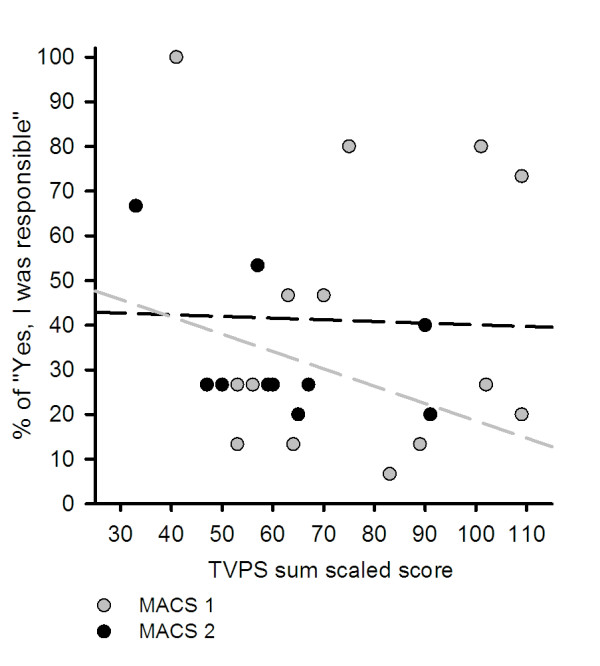
Correlation between the TVSP scores and the reporting of being responsible for the movements. Figure 6 illustrates the correlation between the TVPS scores (x-axis) of the CP children and pooled data of 10, 15 and 20 degrees computer manipulations of the percentage reporting of "Yes" for being responsible for the movement. The graph compares the CP children divided into the MACS score groups. r2 scores for MACS 1 and MACS 2 are 0.2 and 0.0007 respectively.